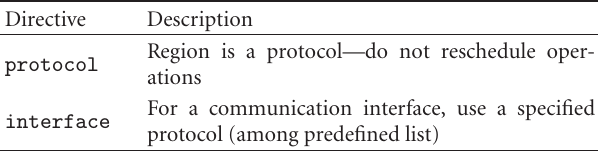
Table 3: For loop directives.